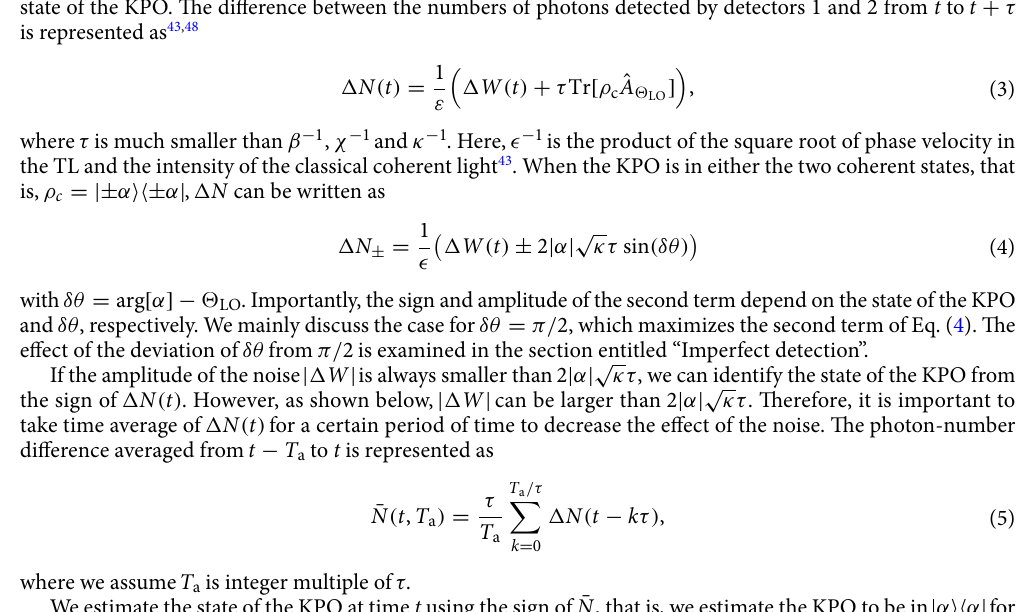
Figure 3. Time dependence of ¯ N and F T a = 10 µ s ( c , f ). The used parameters are the same as in Fig. 2. The data is represented by lines and dots in the upper and lower panels,